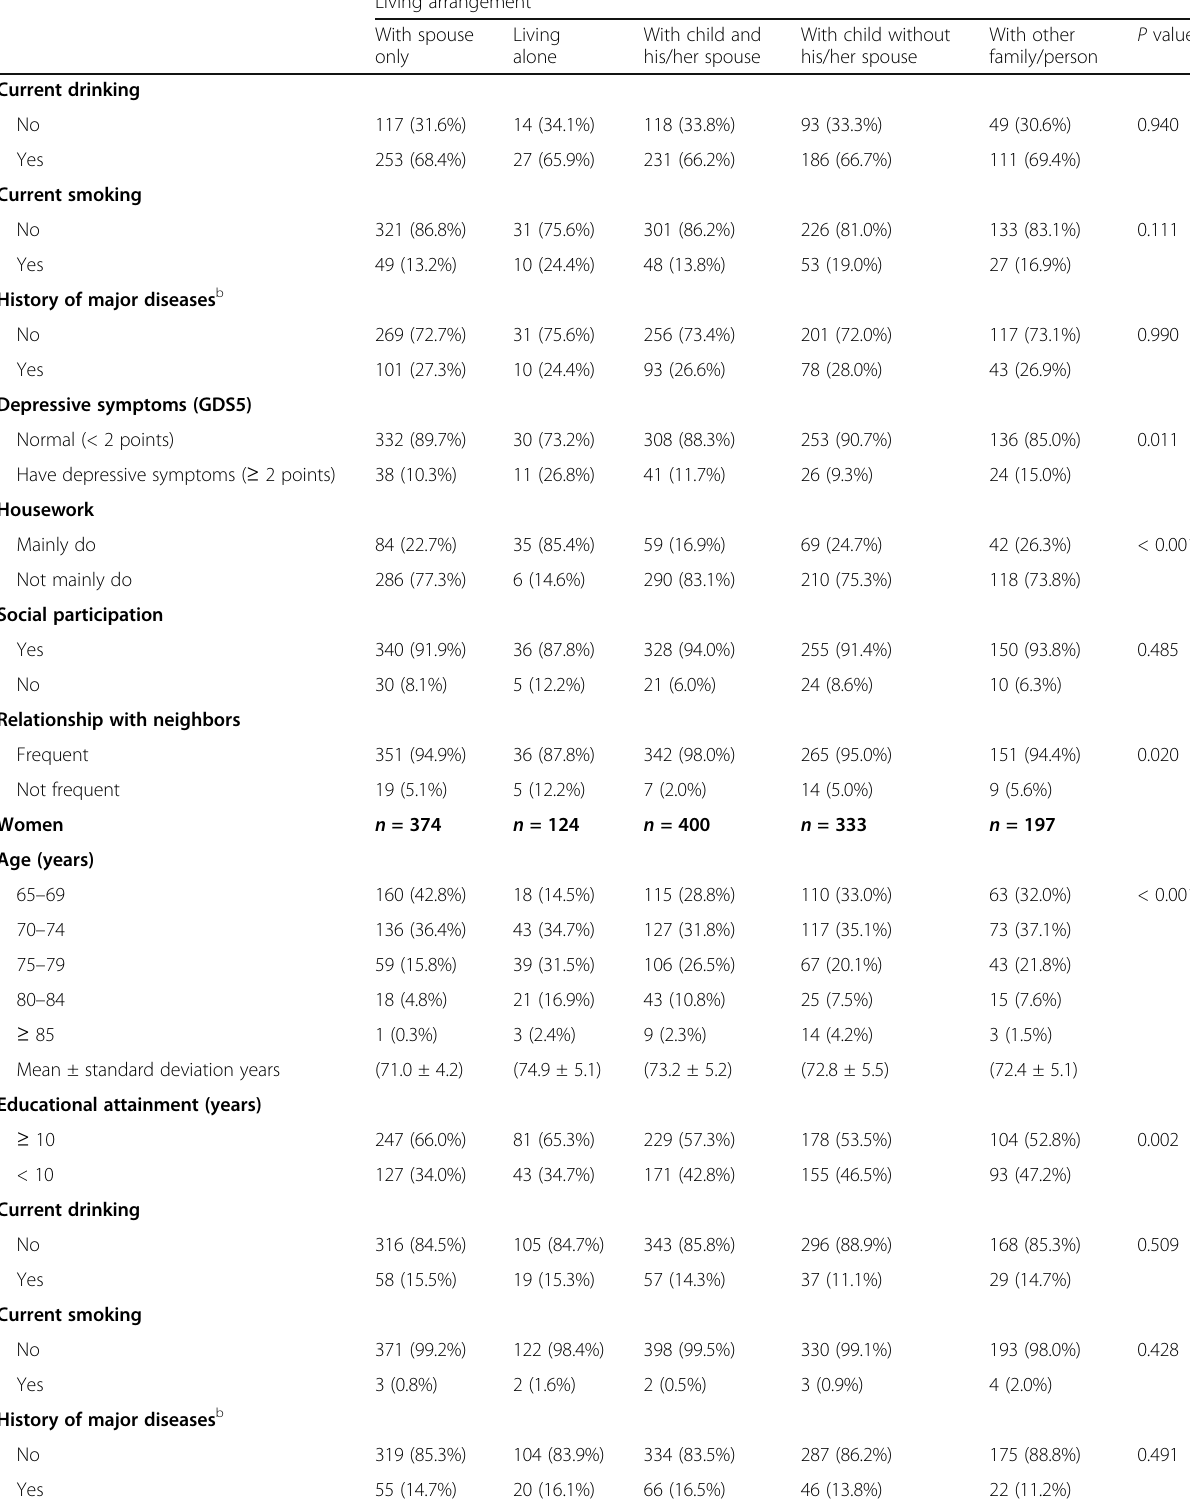
Table 1 Characteristics of the study population at baseline